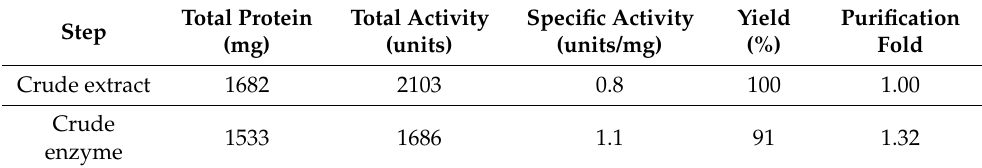
Table 1. Cathepsin L activity of crude extract and crude enzyme from olive flounder.